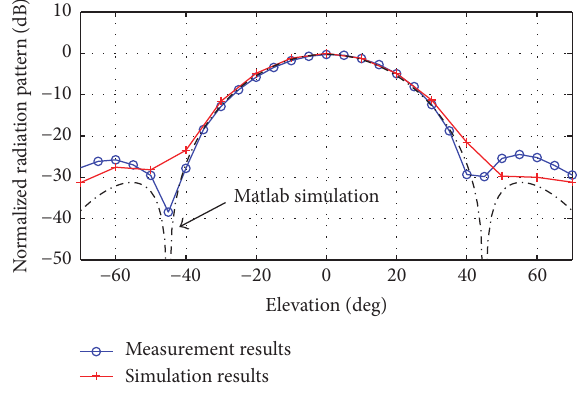
Figure 11: H plane radiation pattern at 922.5 MHz.